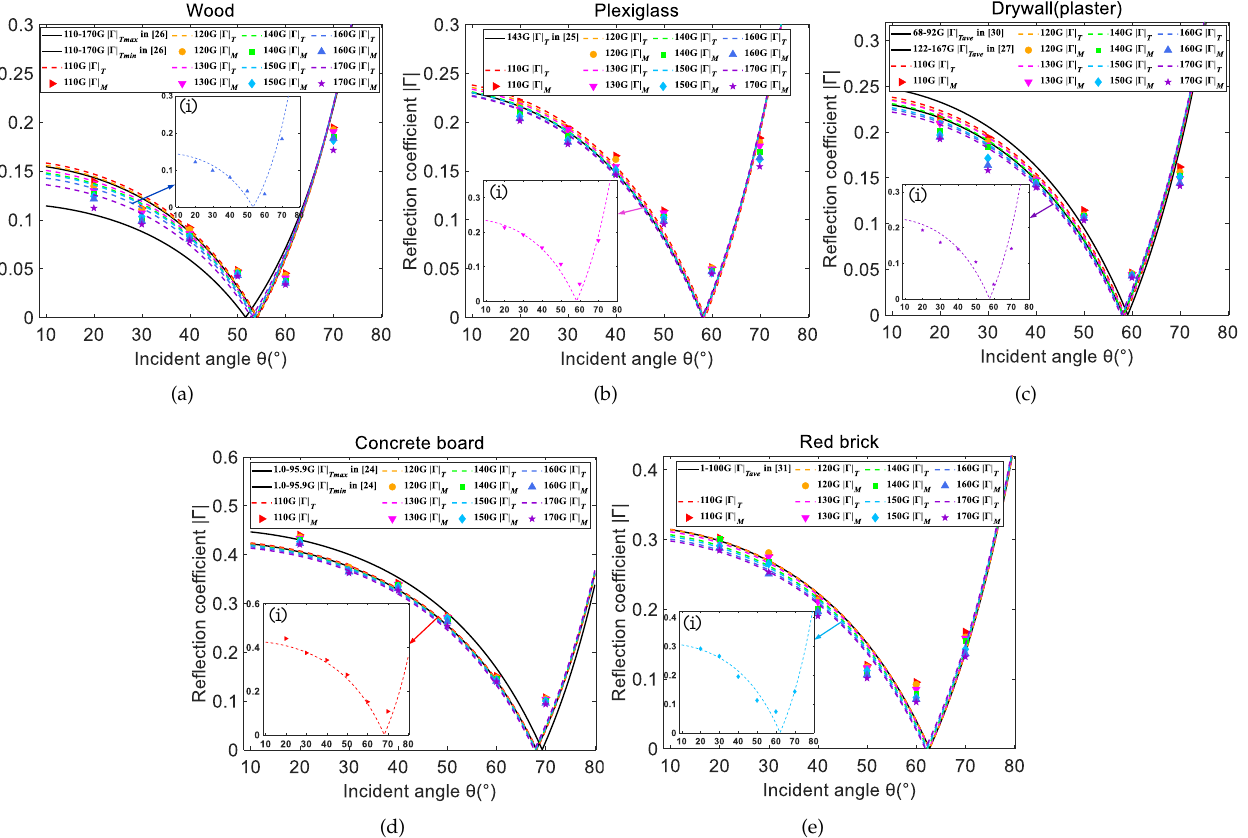
Figure 6. Comparison between measured and Fresnel reflection coefficients for five materials [24–27,30,31].